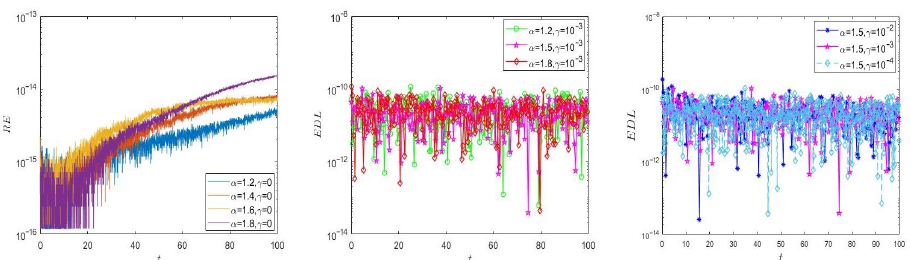
Figure 4. The relative energy errors RE n for γ = 0 and the errors in discrete dissipation-preserving law EDL n for different γ and α with h x = h y = 1/2 and τ = 0.01.